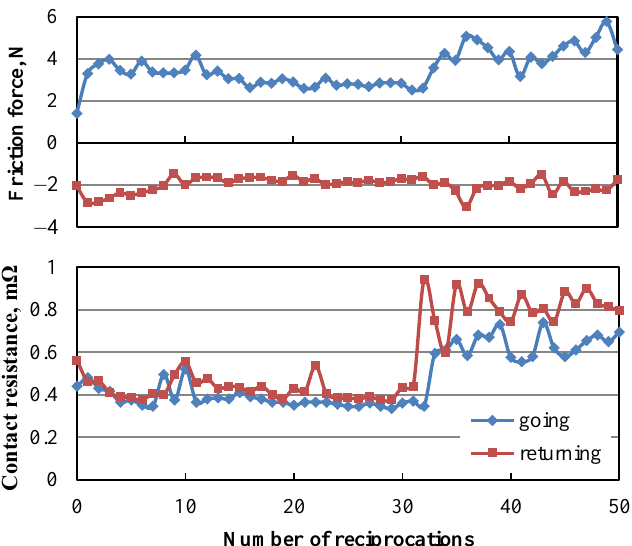
Figure 9. Changes in the frictional force and the contact electrical resistance ( t = 0.2 mm, Ag plating 1 µm, v = 200 mm/min).